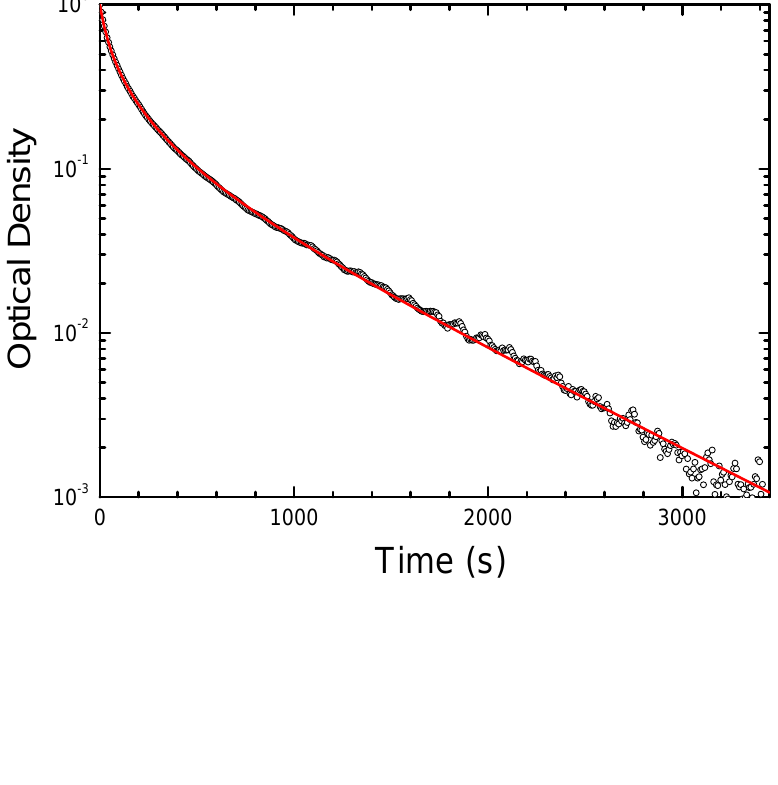
Figure 9. Restoration of the equilibrium concentration of shallow donor states after stoppage of excitation in the UV-VIS absorption band (at t = 0) in CdF crystal at T = 254 K. Points are experimental data; solid line represents the solution of Equation (5) with best-fit